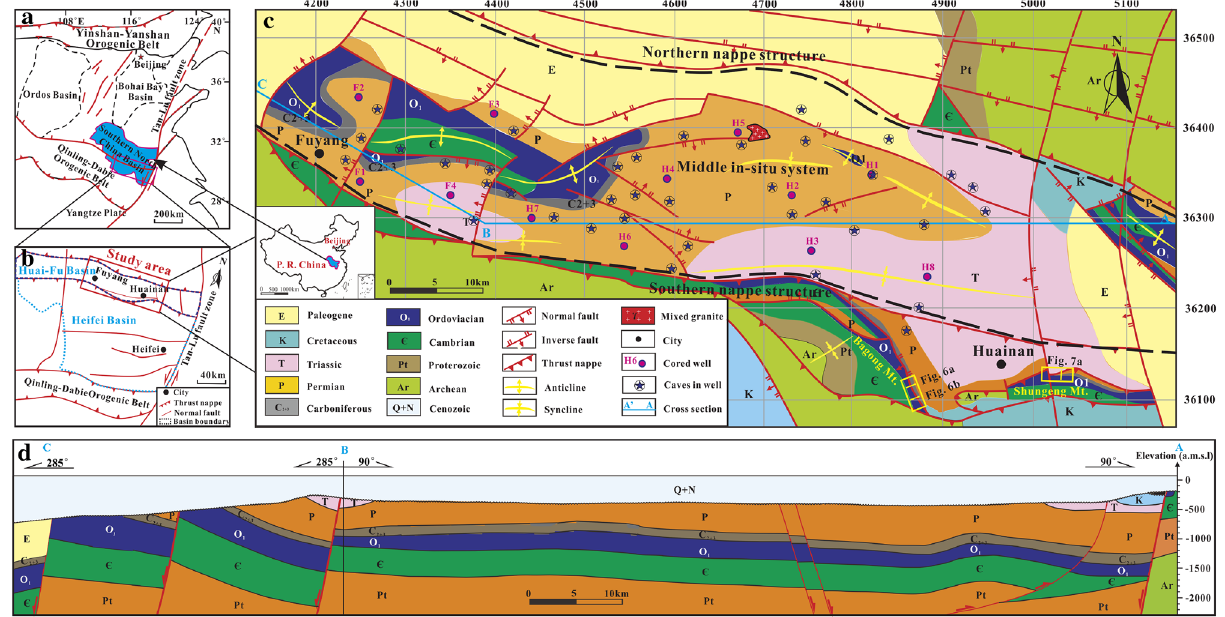
Figure 1. Geological setting of the studied area: ( a ) Distribution of major oil and gas basins in North China; ( b ) Location of the study area; ( c ) Strata, structures and well locations in the Huai-Fu Basin; ( d ) Geological map